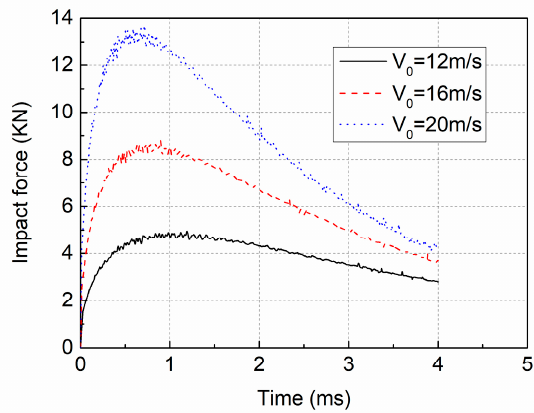
Figure 8. The time history of the impact force with different impact velocities.